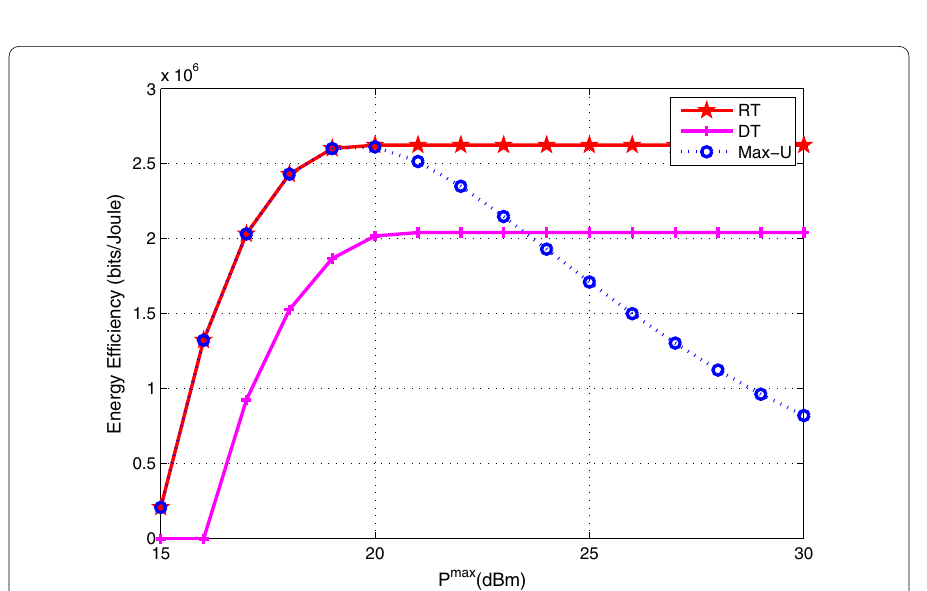
Fig. 6 Energy efficiency versus maximum transmit power allowance P max in different